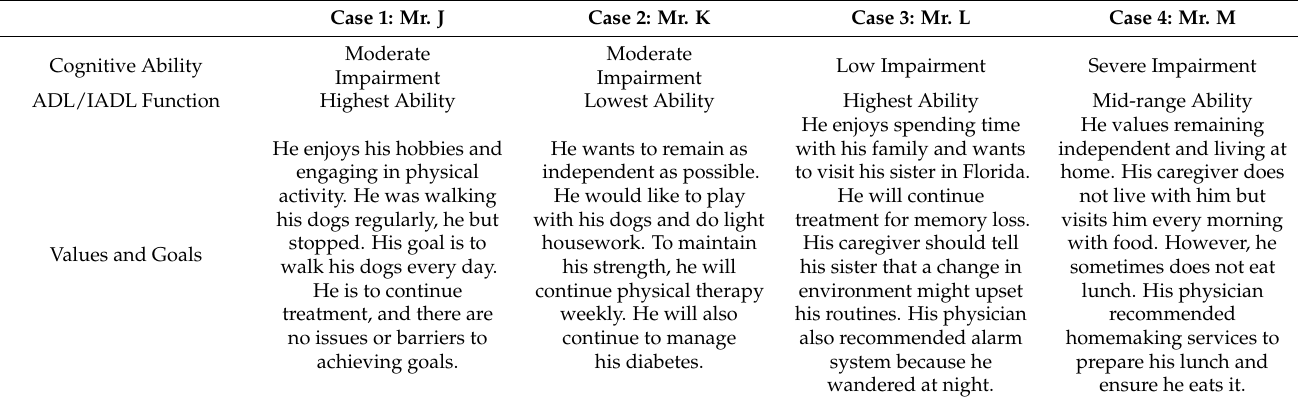
Table 3. Case Descriptions: All measures are reported for a period of 24 h. Change is the difference between measurement at baseline and